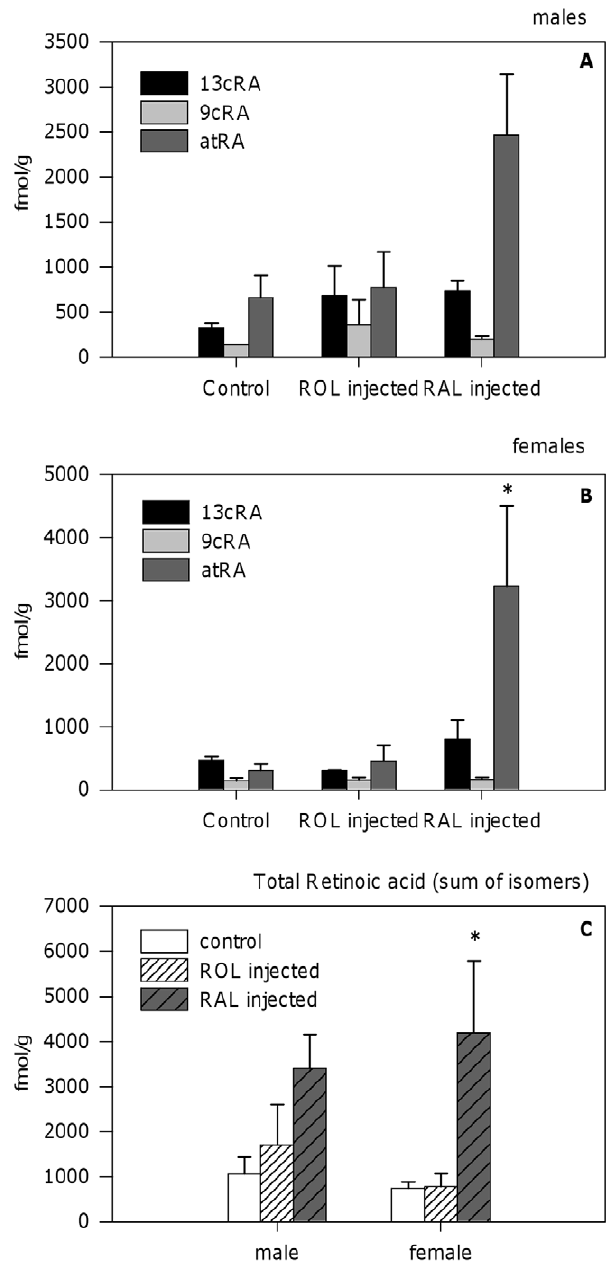
Figure 6. Polar retinoids in Osilinuslineatus after intramuscular injections with retinol or retinaldehyde . Retinoic acid isomers and total retinoic acid (sum of isomers) in digestive gland-gonad complex of O. lineatus after injection with DMSO (control), retinol (4 m g/g body mass), or retinal (4 m g/g body mass). Values represent mean 6 SEM (n=3). Asterisks indicate significant differences from respective control group (P , 0.05, one-way ANOVA followed by the Tukey post-hoc test).